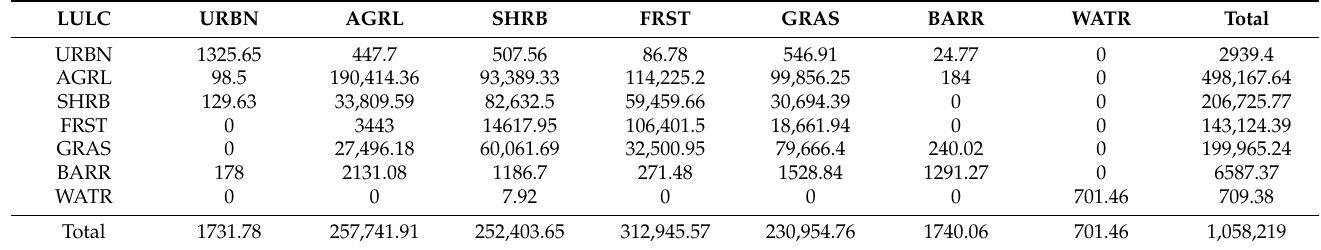
Table 6. LULC change matrix between the years 1986 and 2016 (ha).